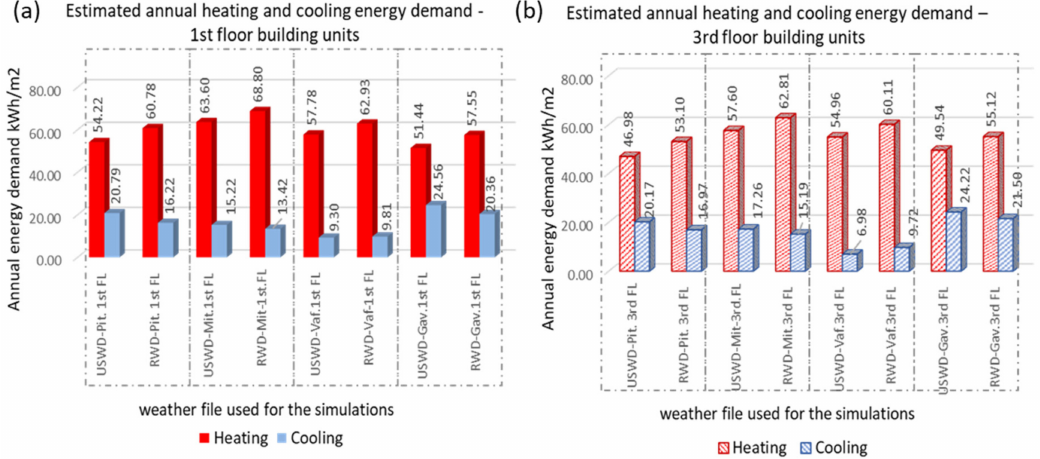
Figure 10. Estimated annual heating and cooling energy demands using the RWD and the USWDS for ( a ) the examined 1st floor building units and ( b ) the 3rd floor building